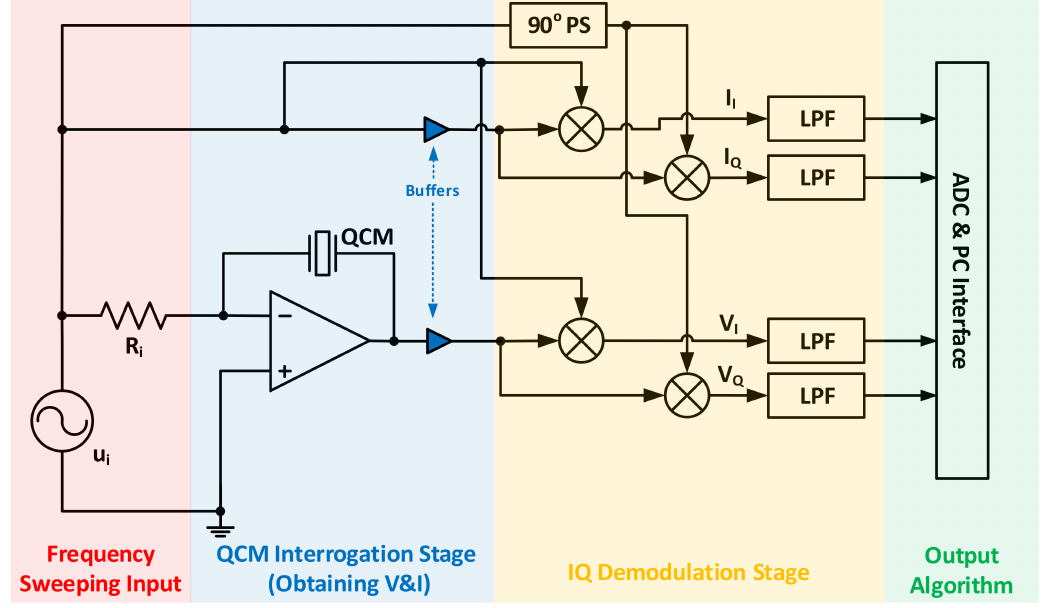
Figure 11. Compact impedance-based characterization system from [73], supporting multiplexing